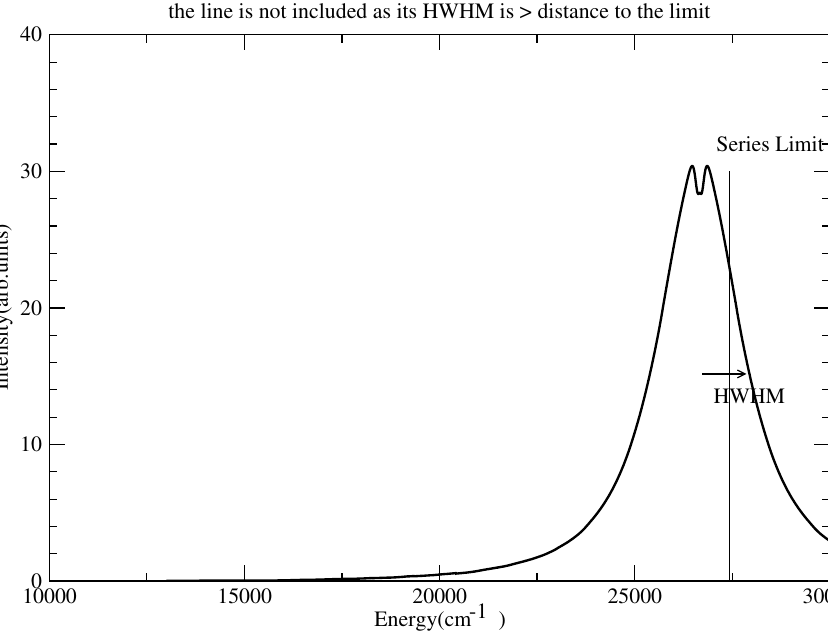
Figure 1. H 12 computed with account of penetrating collisions (PST) at the lowest density considered showing a HWHM that is larger than the distance to the continuum.